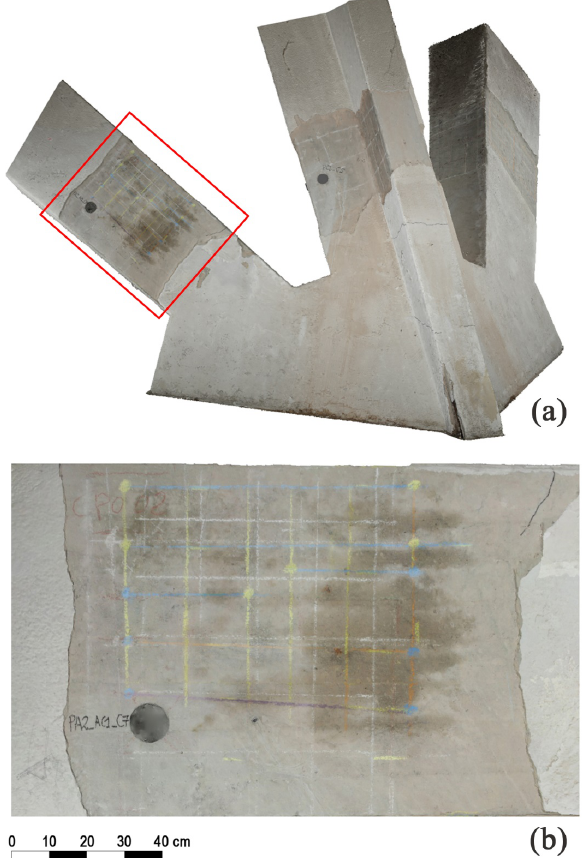
Figure 13 . (a) High-resolution photogrammetric 3D model derived from very close-range acquisitions. (b) High- resolution orthoimagery (GSD < 1 mm) of one of the investigated